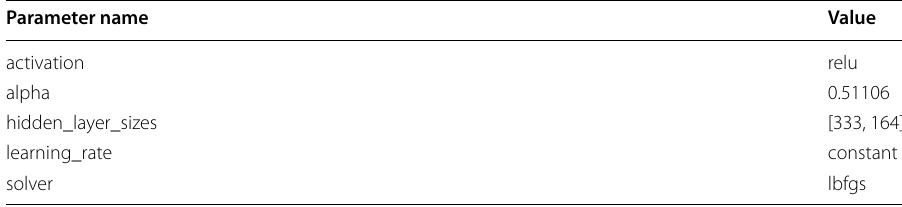
Table 83 Modes of MLP tuned hyperparameter values for experiments with the data exfiltration dataset